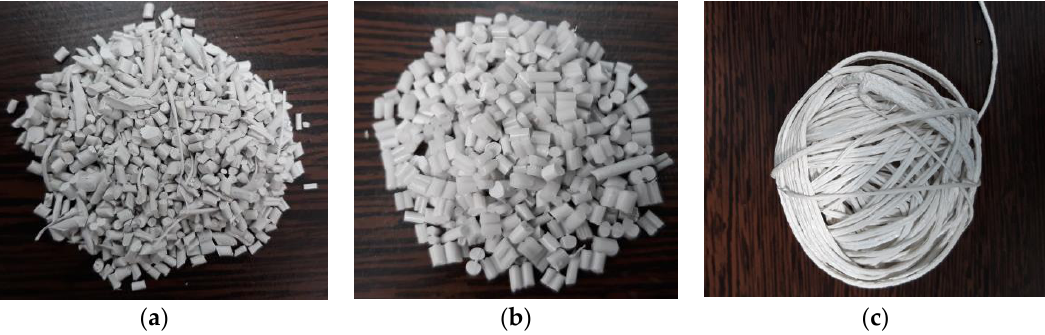
Figure 17. TPU/PP/BaTiO 3 composite granules ( a ) first pass through the extruder, ( b ) second pass through the extruder, ( c ) the filament.